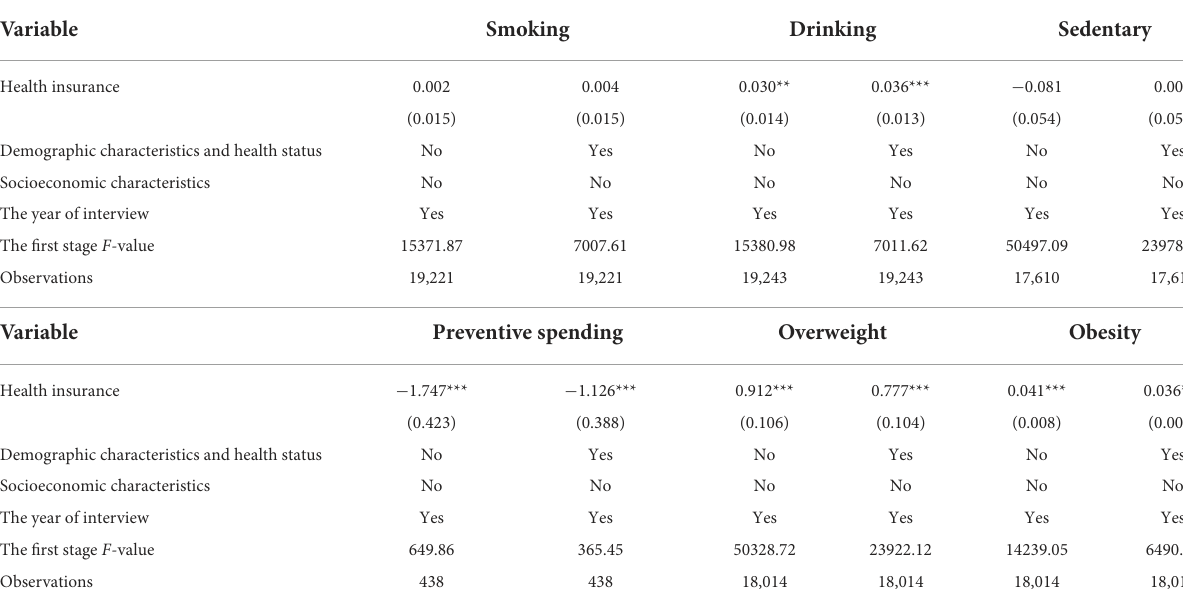
TABLE 10 Robustness check 3.